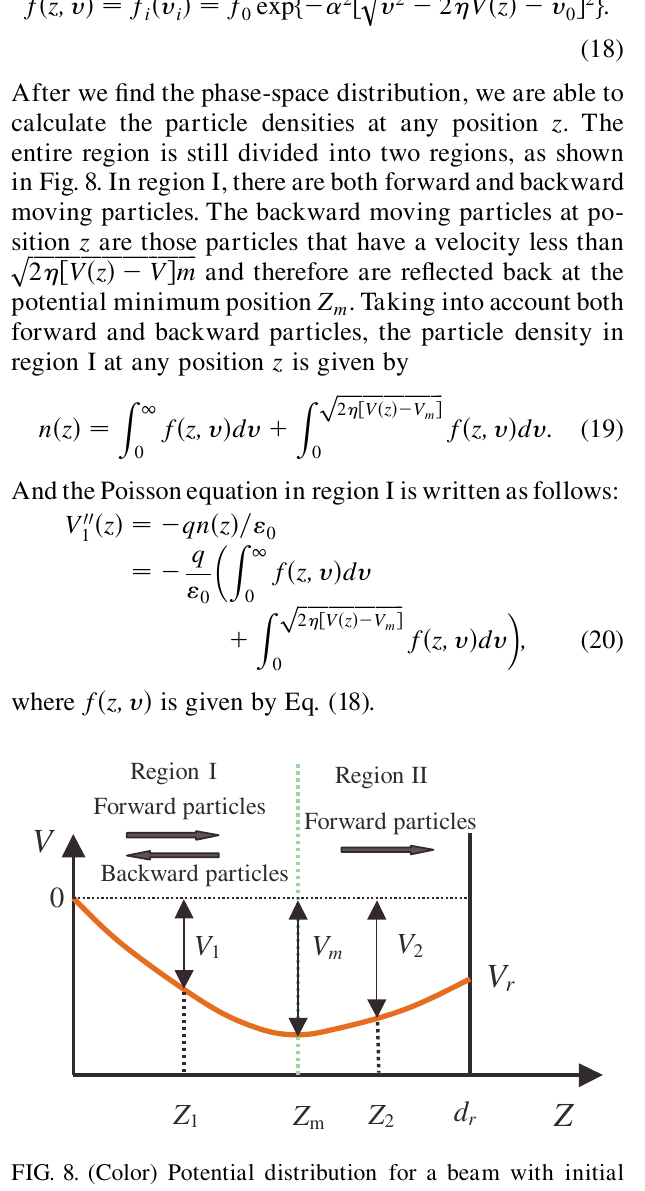
FIG. 8. (Color) Potential distribution for a beam with initial energy spread.